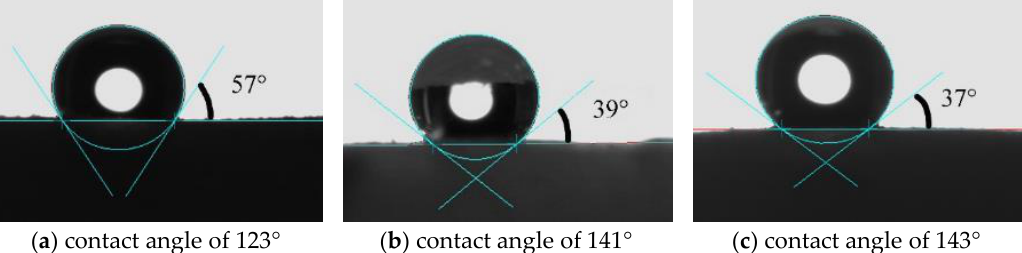
Figure 4. Contact angle images of flexible MSQ aerogels (without surface modification) prepared with varied volume ratios of co-precursor: ( a ) V DMDMS /V MTMS =0; ( b ) V DMDMS /V MTMS = 0.6; ( c ) V DMDMS /V MTMS = 1.0.